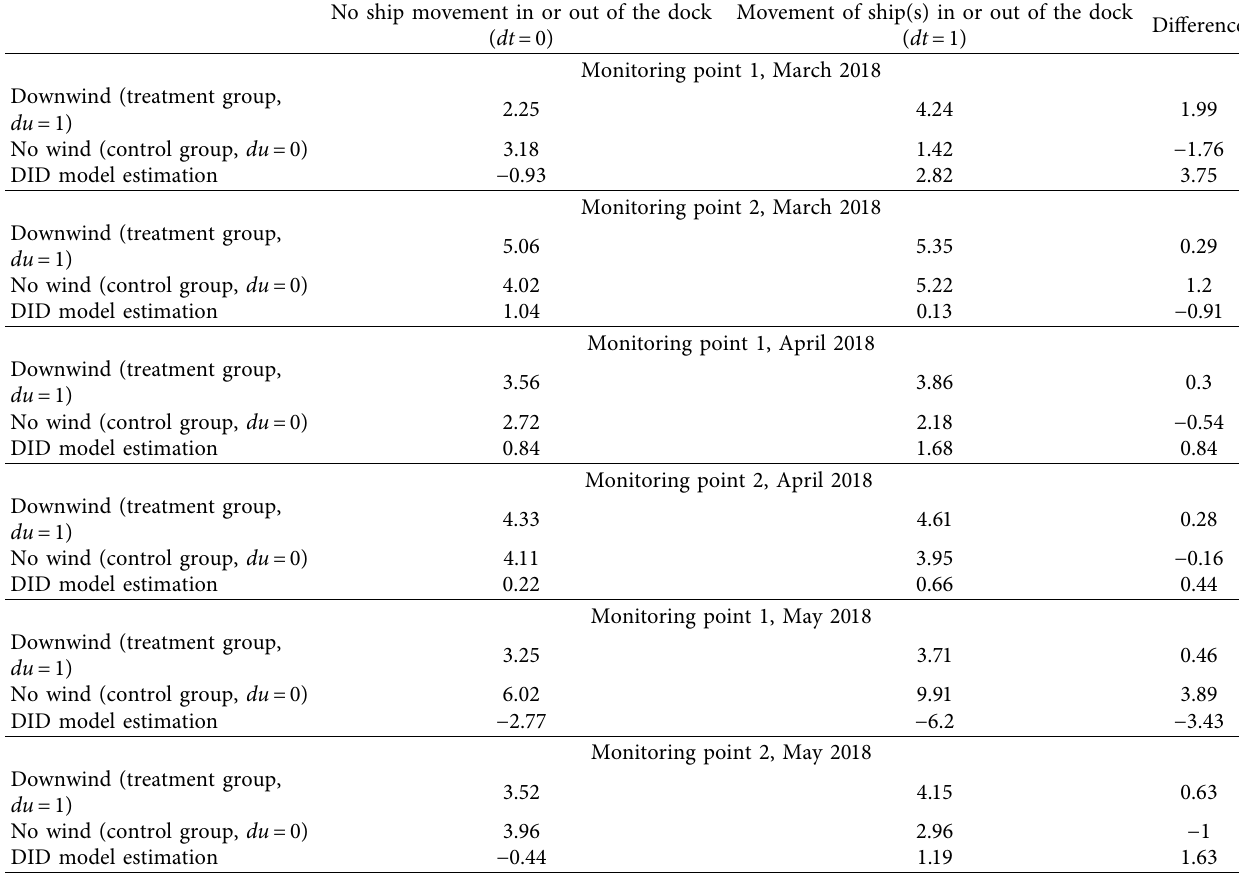
Table 2: DID model